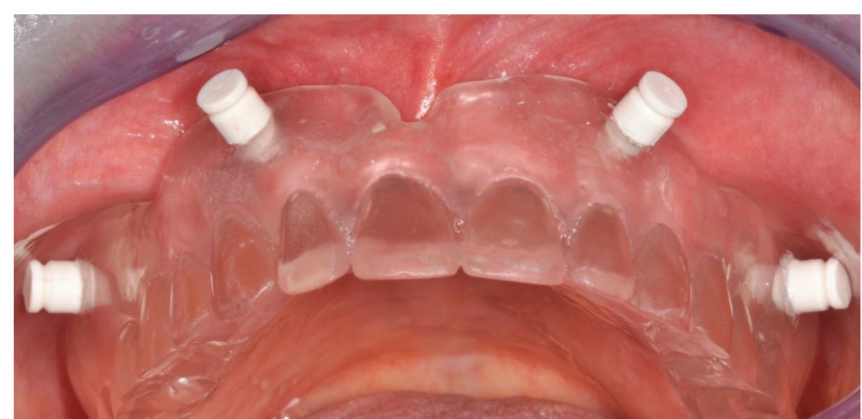
Figure 2. Clinical view of an edentulous maxilla before treatment.